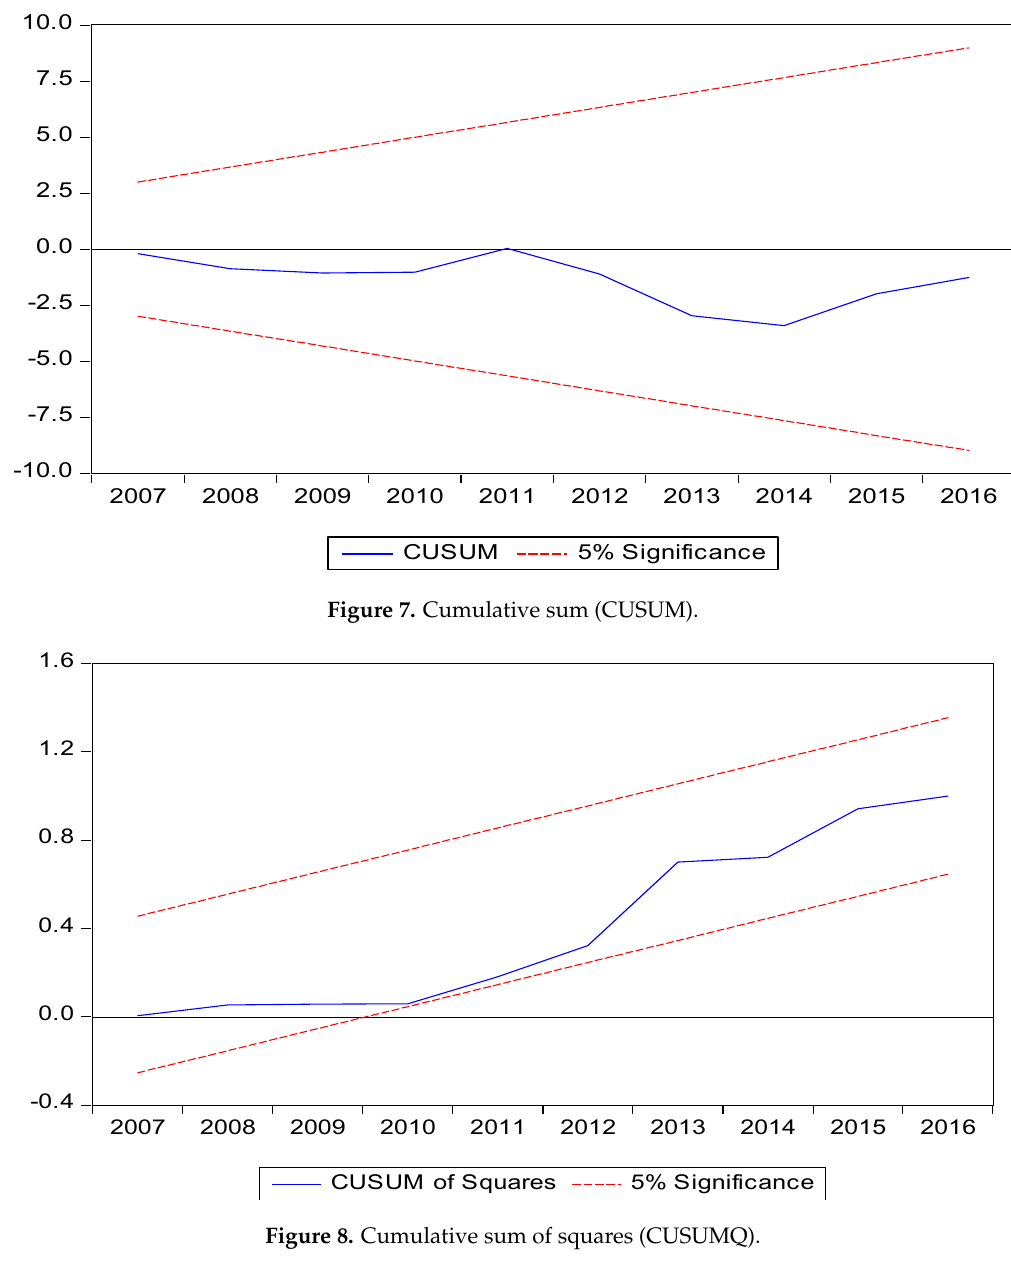
Figure 8. Cumulative sum of squares (CUSUMQ).